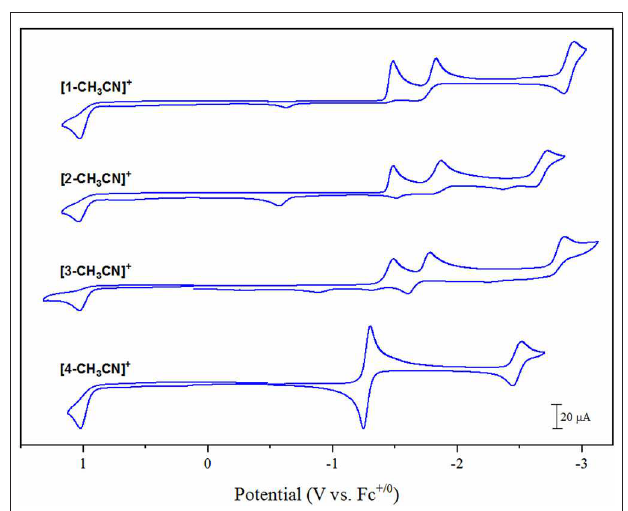
FIGURE 3 | Cyclic voltammograms of [1-CH 3 CN] + , [2-CH 3 CN] + , [3-CH 3 CN] + and [4-CH 3 CN] + recorded in 0.1M [Bu 4 N][PF 6 ] acetonitrile supporting electrolyte at a glassy carbon working electrode with a scan rate of υ = 0.1V s − 1 under 1 atmosphere of